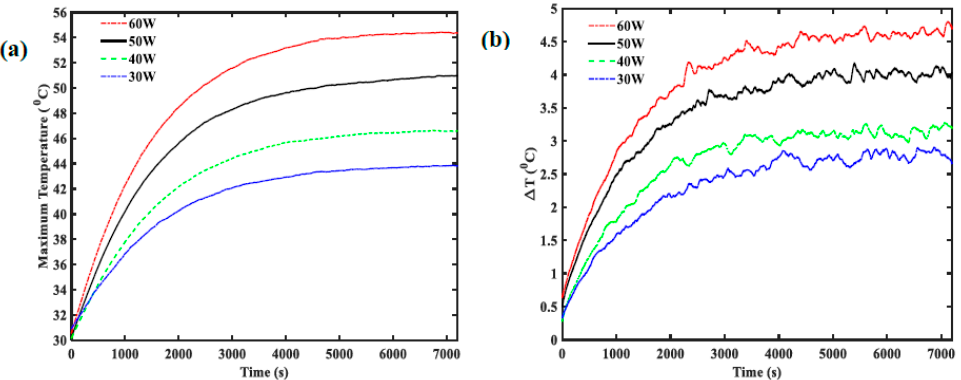
Figure 4. The variation of ( a ) T max and ( b ) ∆ T at different input powers and a mass flow rate of 0.0167 kg/s (from Mbulu et al. [5], with permission from